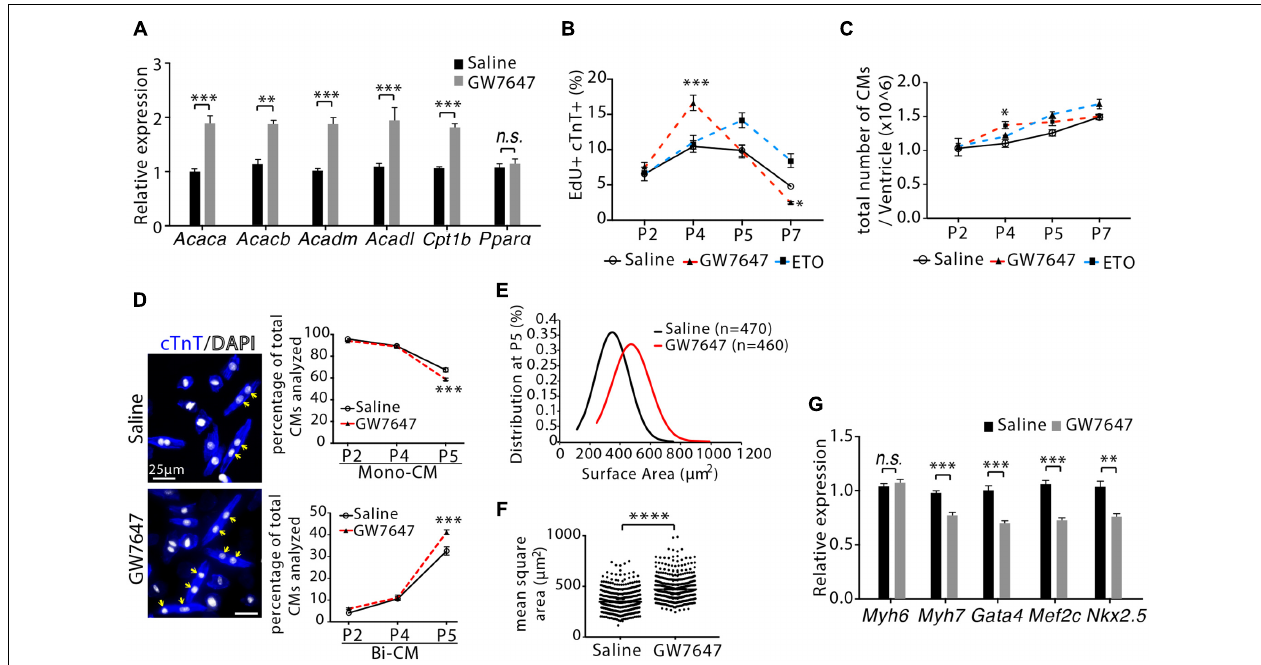
FIGURE 5 | Cardiomyocyte proliferation and hypertrophic growth in GW7647-treated infant mouse hearts. (A) Infant mice were treated either with GW7647 or saline at P2, P3 and P4. Quantification of genes associated with fatty acid metabolism by qRT-PCR analysis of the mRNA of isolated heart ventricles at P5 ( n = 4 per group). (B) Quantification of EdU+cTnT+ cells as percentage of total cTnT+ cells isolated from heart ventricles at indicated time points ( n = 6 per group, ∼ 1000 cTnT+ cells per sample). (C) Quantification of total number of cardiomyocyte isolated from heart ventricles at indicated time points ( n = 4–8 per